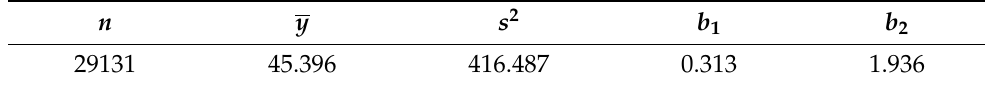
Table 7. Kaposi’s sarcoma: Descriptive statistics.